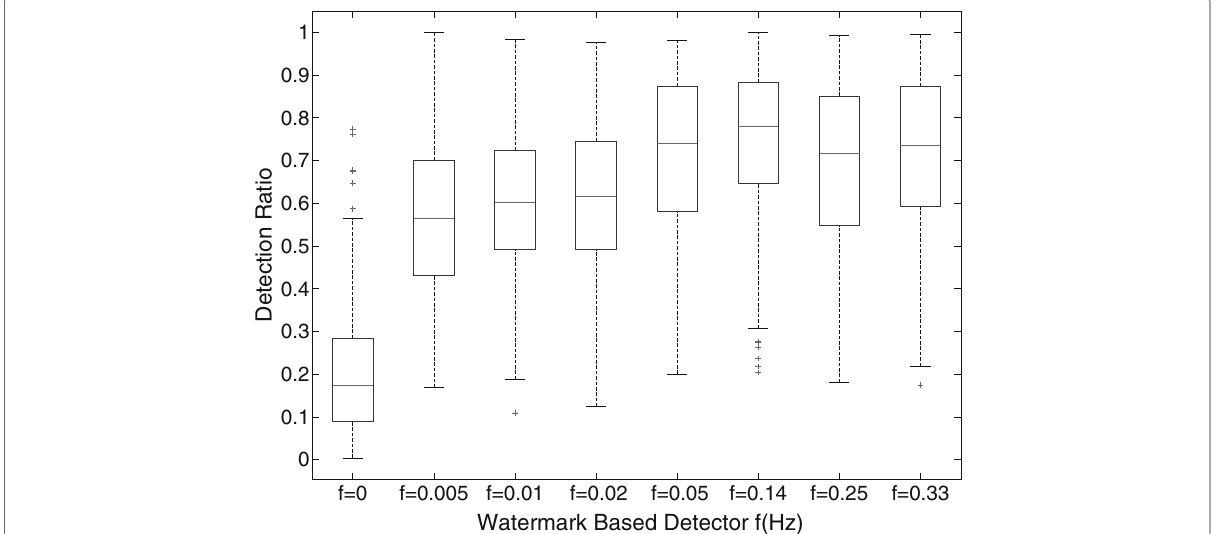
Fig. 9 Single- ( f = 0) and multi- ( f = [0.005, 0.01, 0.02, 0.05, 0.14, 0.25, 0.33]) watermark detectors against a non-parametric cyber-physical adversary (the order of the system is